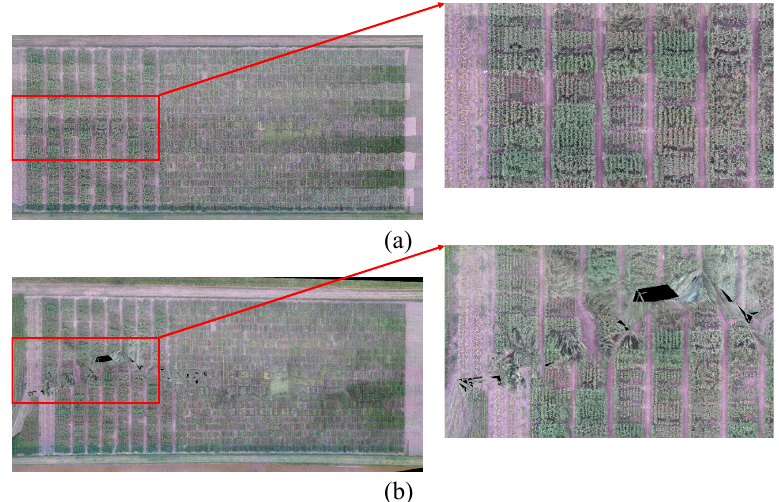
Figure 15. The generated RGB-based orthophoto mosaic and close-ups from ( a ) the proposed automated aerial triangulation, and ( b ) Pix4D for Phantom2-Agriculture Dataset.